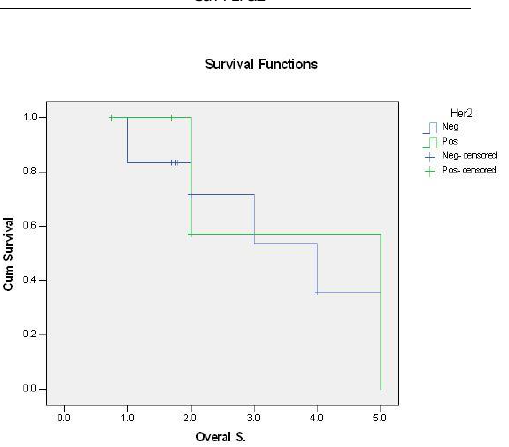
Fig. 4. HER2/neu overexpression and overall survival